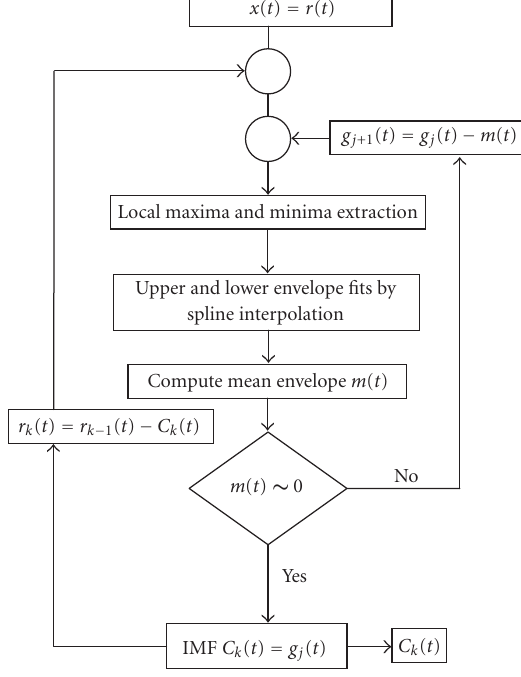
Figure 2.1. Sifting scheme in the empirical mode